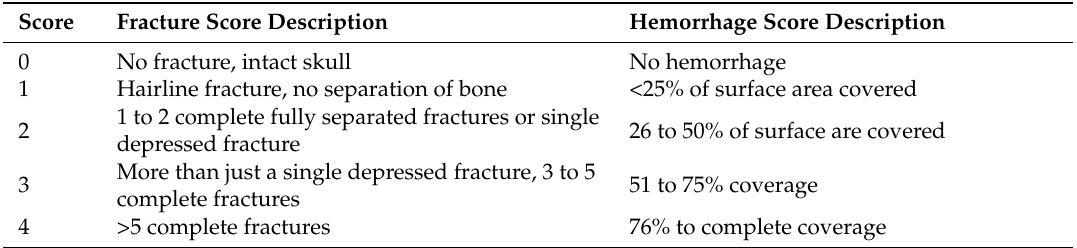
Table 1. Scoring system for grading skull fractures and macroscopic subcutaneous and subdural hemorrhage in rabbits euthanized by different methods.